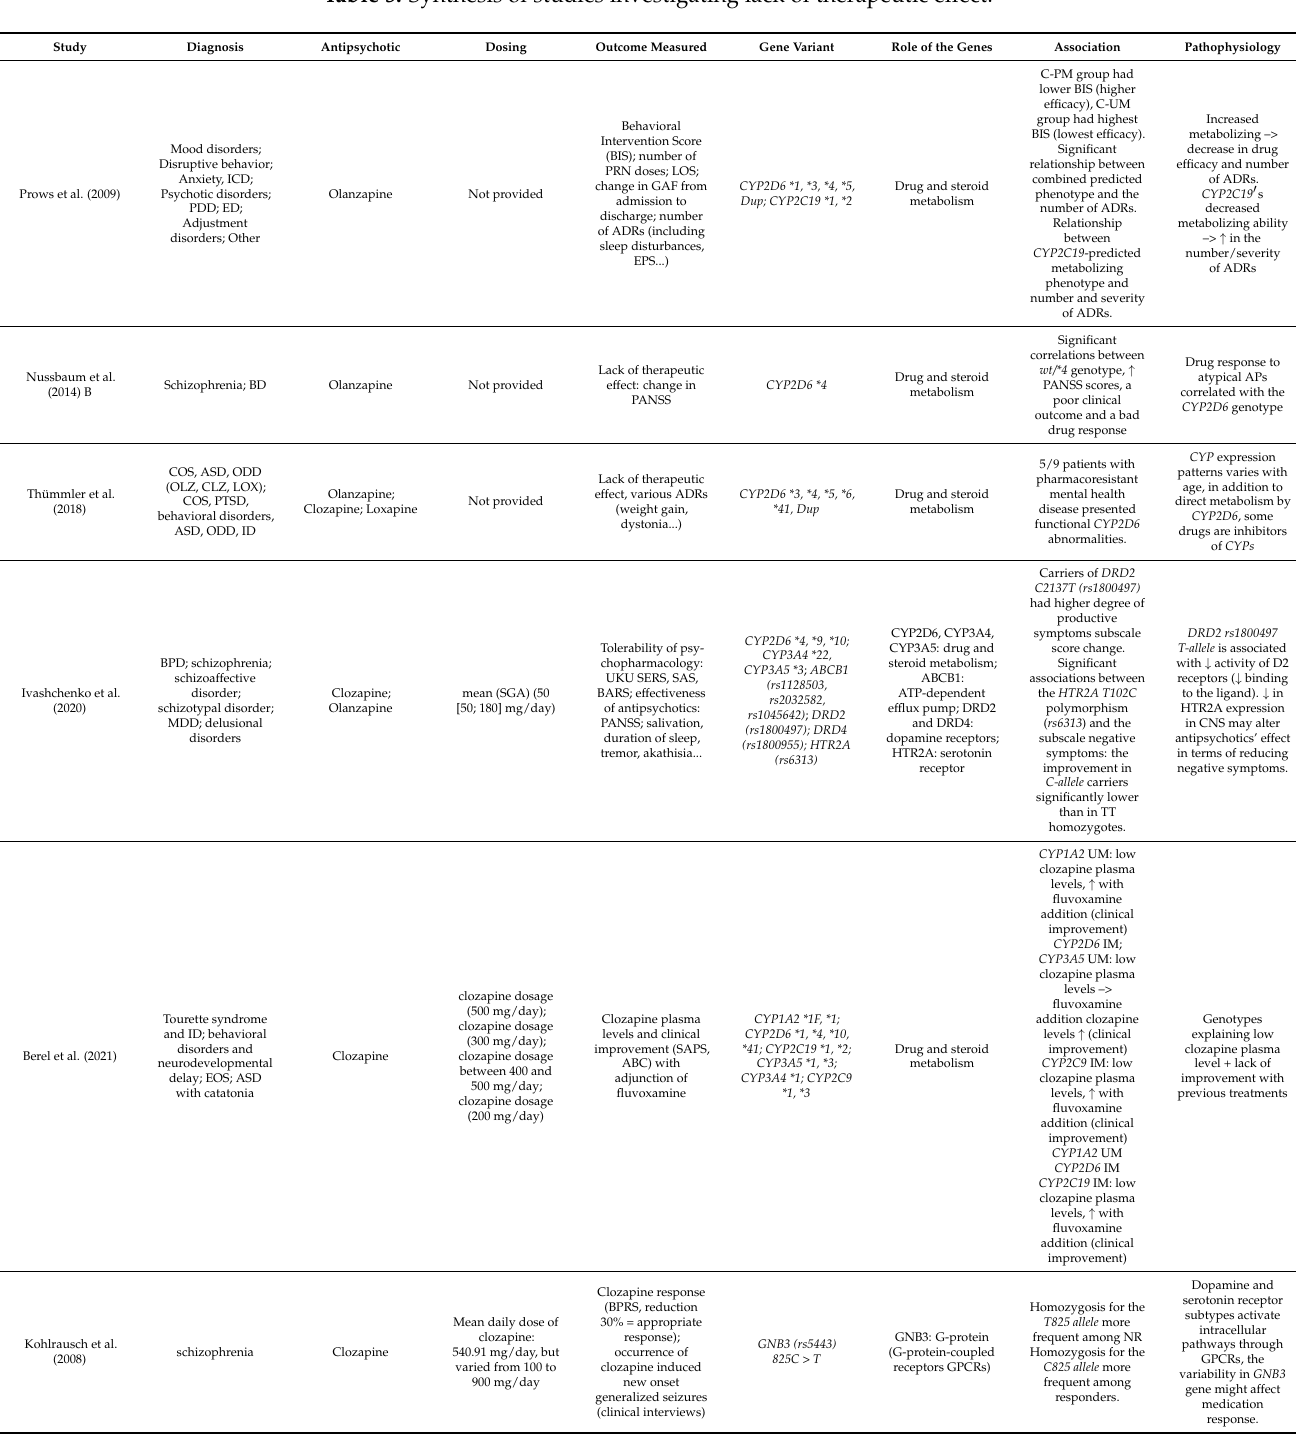
Table 5. Synthesis of studies investigating lack of therapeutic